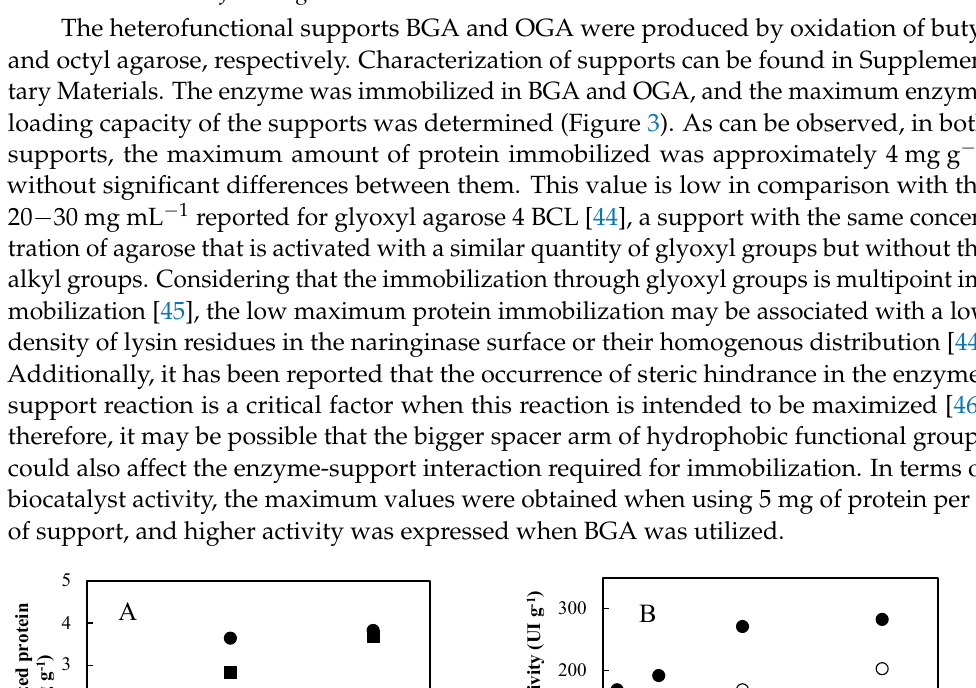
Figure 2. Effect of ( A ) pH and ( B ) temperature on the relative activity of free naringinase using, as substrate, ∎ p -nitrophenyl-β-D-Glucoside ( p NPG) and ⯅ p -nitrophenyl-α- L -rhamnopyranoside ( p NPR).